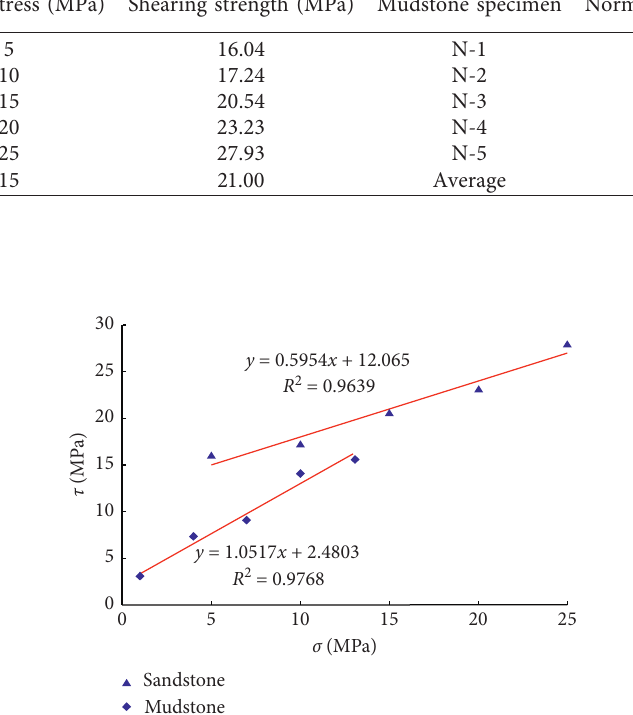
Table 2: Rock shear testing data.